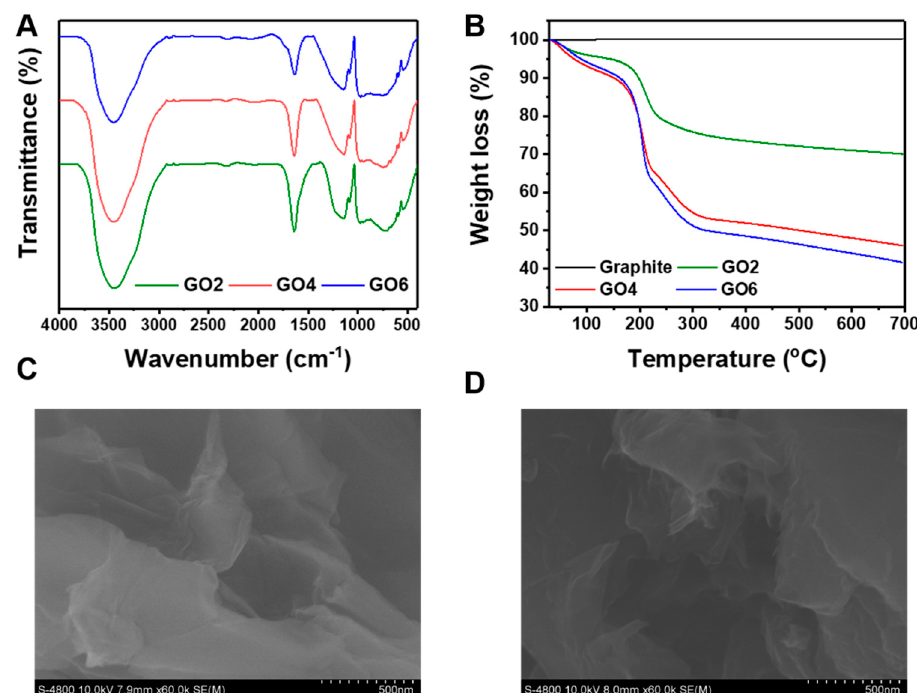
Figure 1. ( A ) Fourier-transform infrared (FTIR) spectra and ( B ) Thermogravimetric analysis of GO2 (red line), GO4 (blue line), GO6 (black line) and graphite (square dotted line); ( C , D ) Scanning electron microscopic (SEM) images of GO6 dispersed in deionized water solution.